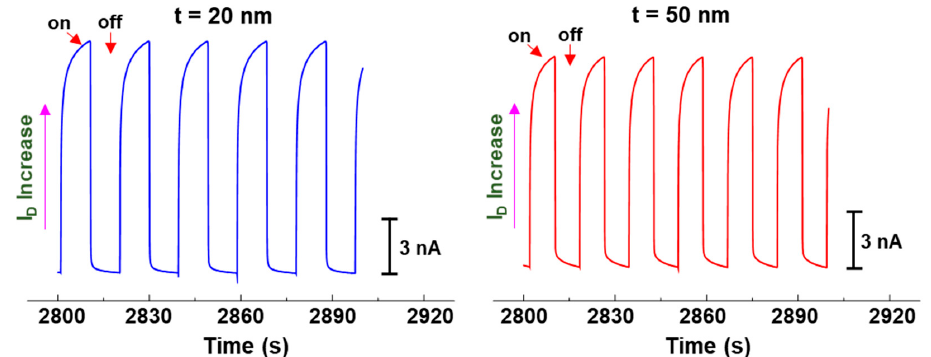
Figure 7. Drain current change with time upon illumination with the optically modulated NIR light (P IN = 0.695 mW/cm 2 , 905 nm) for the optimized NIR-OPTRs with the CDS structures at V D = − 30 V and V G = − 30 V: ( left ) t = 20 nm, ( right ) t = 50 nm.